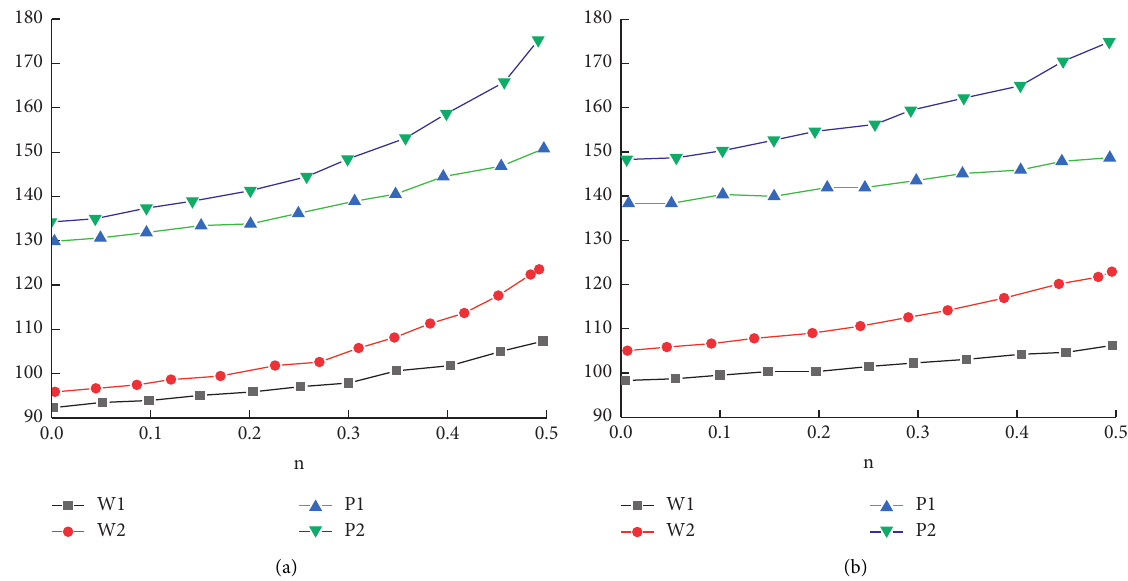
Figure 4: Relationship between retail price, wholesale price, and advertising sensitivity. (a) Short-term advertising sensitivity and (b) long- term advertising sensitivity.